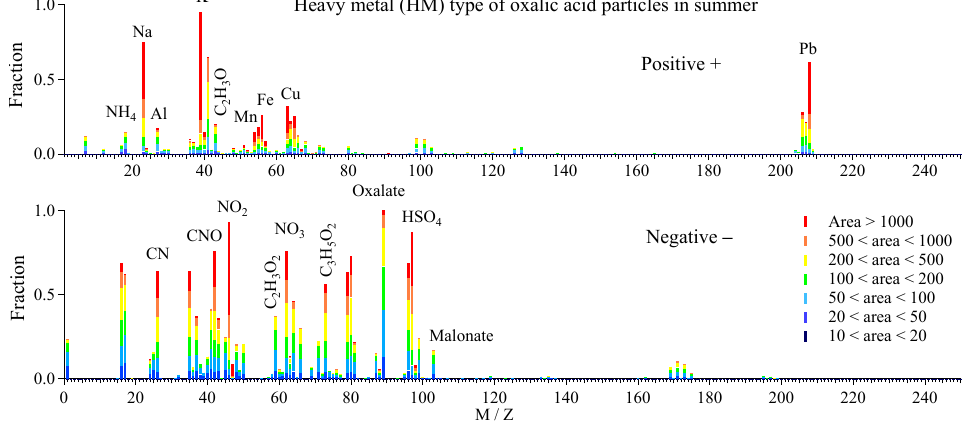
Figure 6. The averaged digitized positive and negative ion mass spectra of heavy metal oxalic-acid-containing particles in summer.